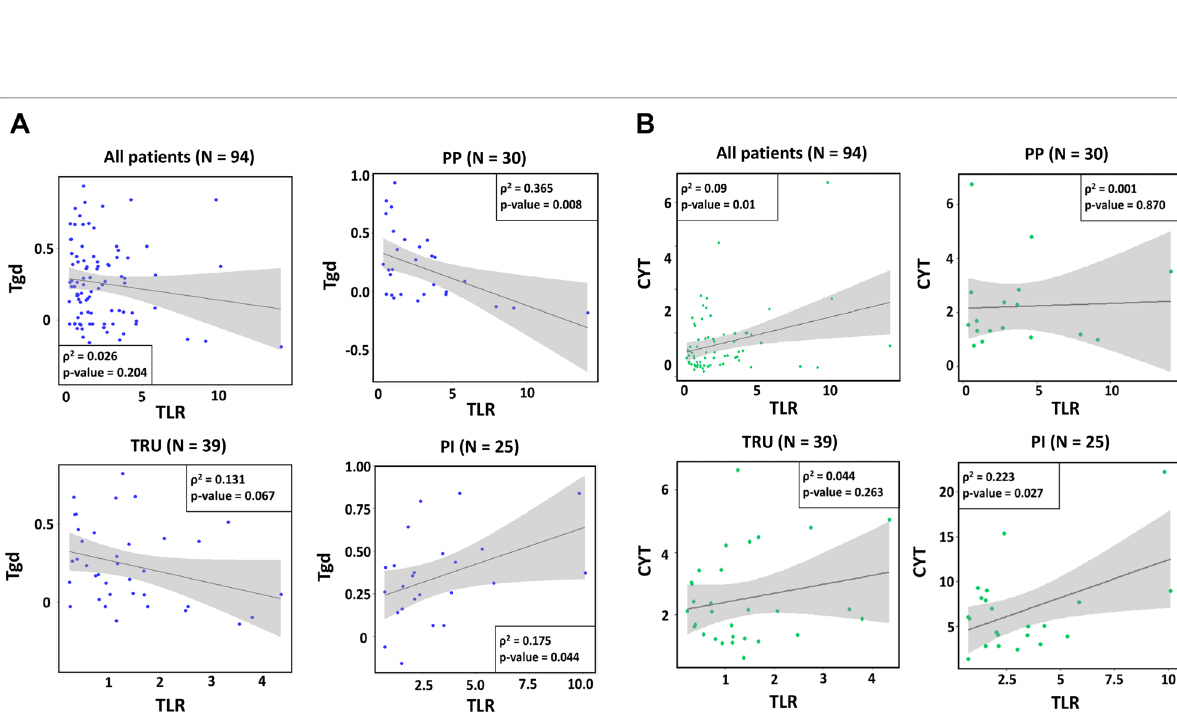
Fig. 4 Correlation between 18 F‑FDG parameter and immune cells: A scatter plots for a correlation analysis of TLR and Tgd, and B scatter plots for a correlation analysis of TLR and CYT. The boxes in each scatter plot show the coefficient of determination and the p value. The dark gray line is a linear regression line, and the gray region is the 95% confidence